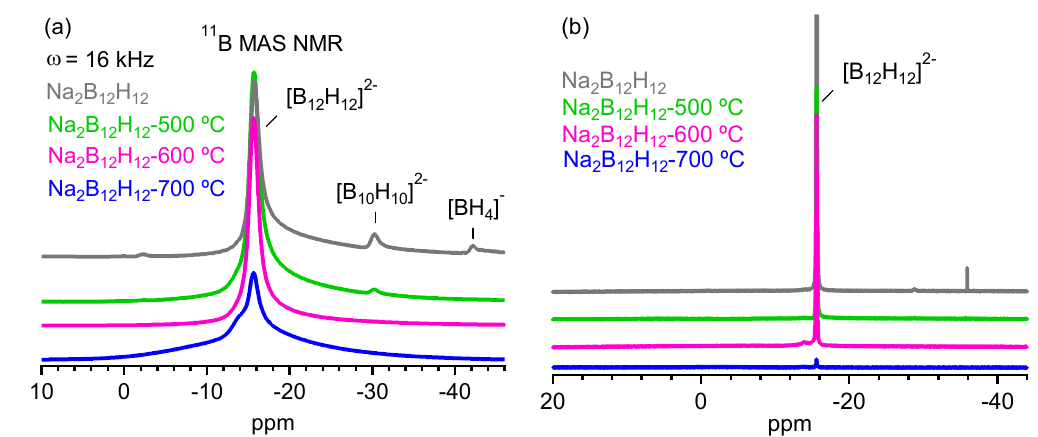
Figure 5. Ex-situ ( a ) XRD patterns and ( b ) Raman spectra of anhydrous Na 2 B 12 H 12 as synthesized and heated up to respective temperatures.